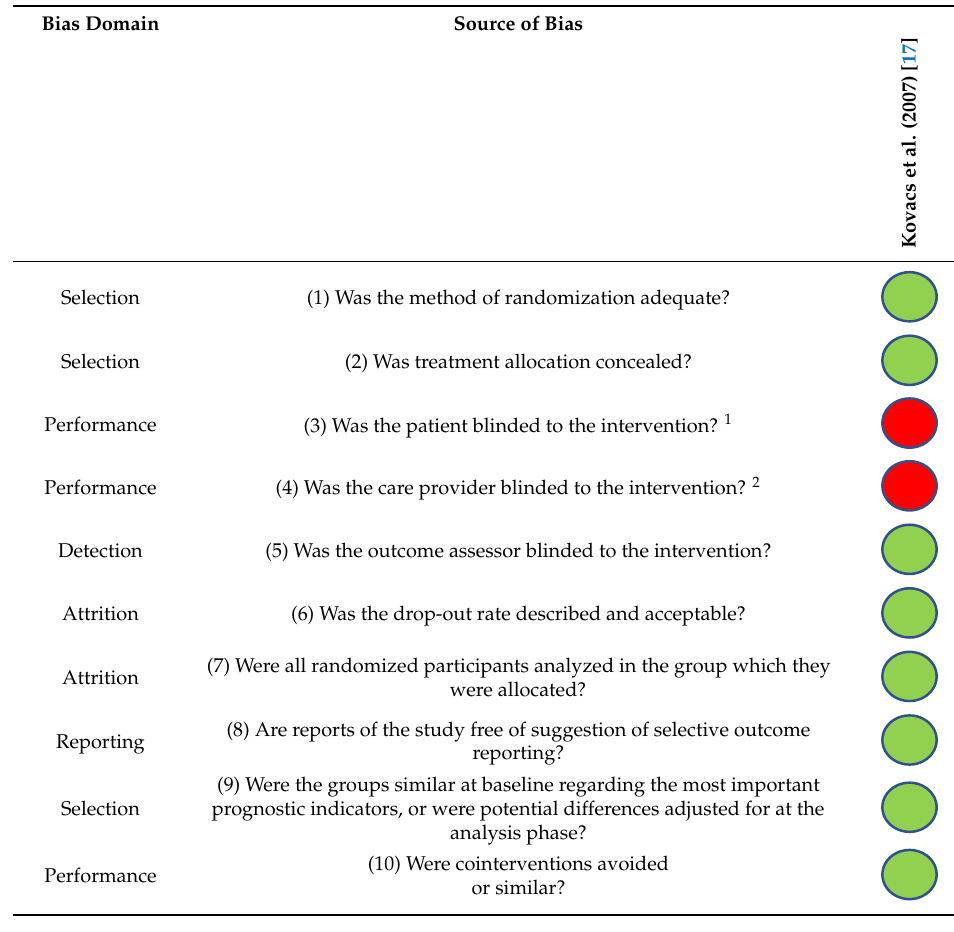
Table 3. Sources of Risk of Bias